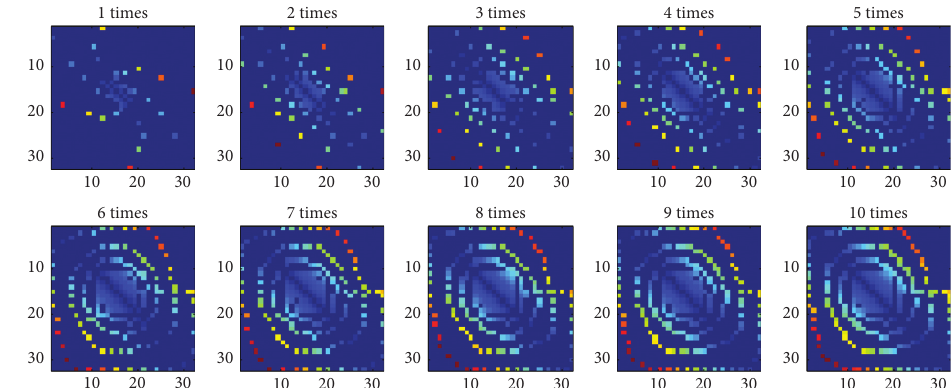
Figure 2: Mesh phase portraits of different multiple sampling frequencies.